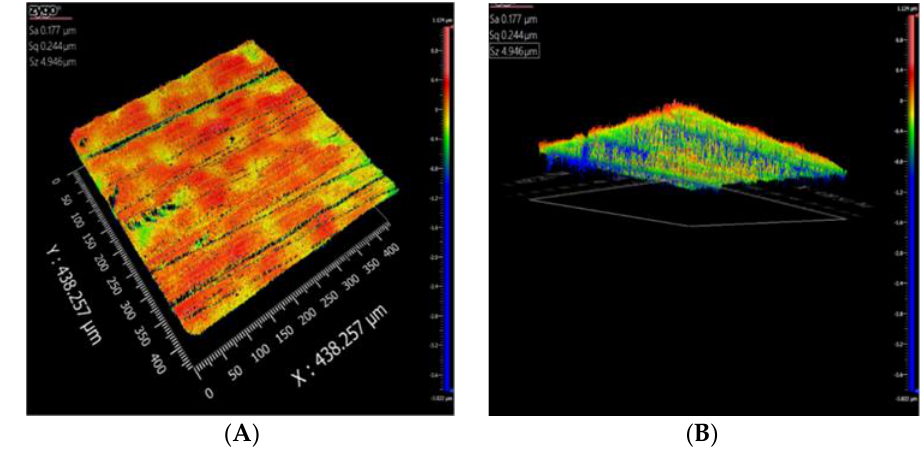
Figure 8. ( A ) Three-dimensional- and ( B ) bottom-view of SPEEK:PSf membranes showing the surface morphology.